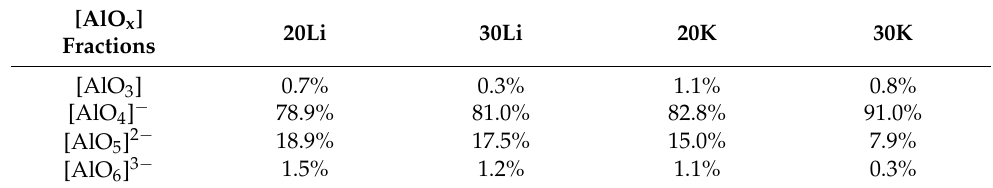
Table 5. The fractions of [AlO x ] groups with three-, four-, five- or six-fold oxygen coordination in the simulated alkali aluminosilicate